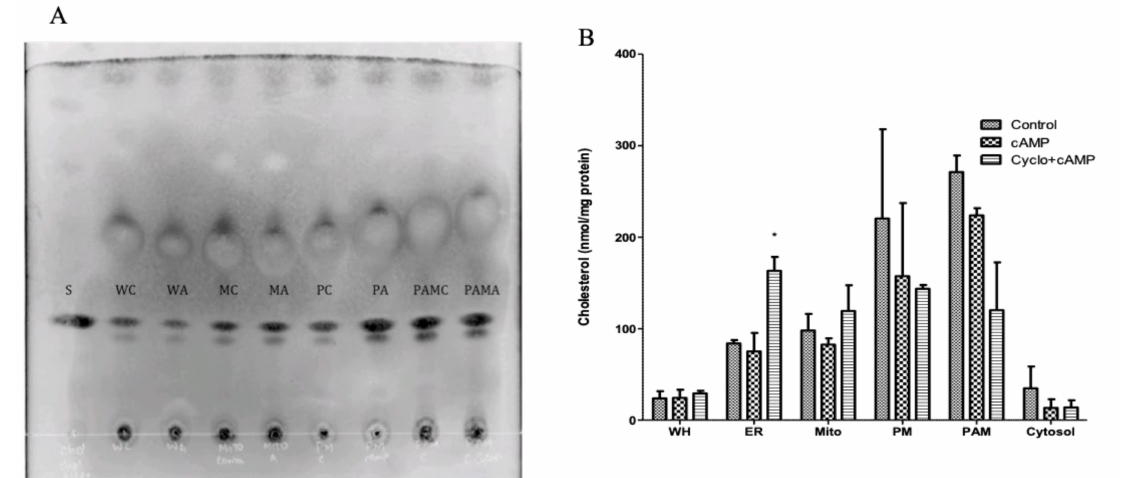
Figure 3. Cholesterol levels in subcellular fractions from MA-10 cells. ( A ) Lipids were isolated from organelle fractions. L: ladder; S: cholesterol standard; WC: whole cell lysate from control cells; WA: whole cell lysate from dbcAMP-treated cells; MC: isolated mitochondria from control cells; MA: isolated mitochondria from dbcAMP-treated cells; PC: isolated PM from control cells; PA: isolated PM from dbcAMP-treated cells; PAMC: isolated PAMs from control cells; PAMA: isolated PAMs from dbcAMP-treated cells. ( B ) Organelle cholesterol distribution was measured by LC–MS/MS in whole cell lysate (WH), endoplasmic reticulum (ER), mitochondria (Mito), plasma membrane (PM), plasma membrane-associated membrane (PAM), and cytosol fractions from the control, dbcAMP-treated, and dbcAMP plus cycloheximide-treated MA-10 cells. Data are shown as mean ± SEM; n = 2; * p <